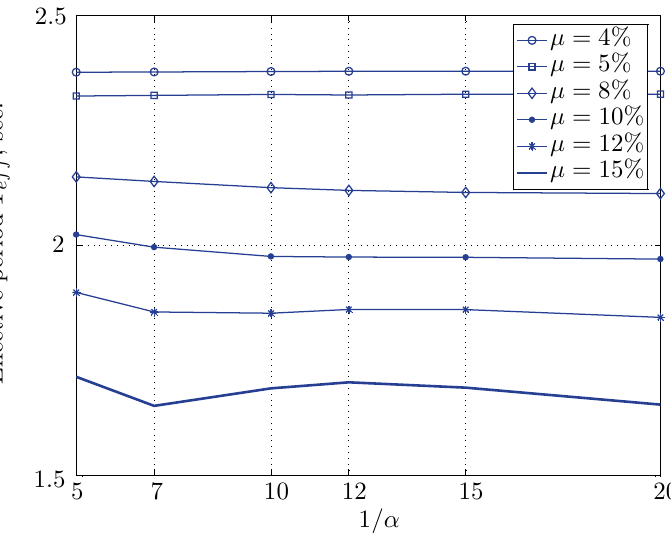
Figure 17. Effective period for various isolation system parameters (El Centro 1979).